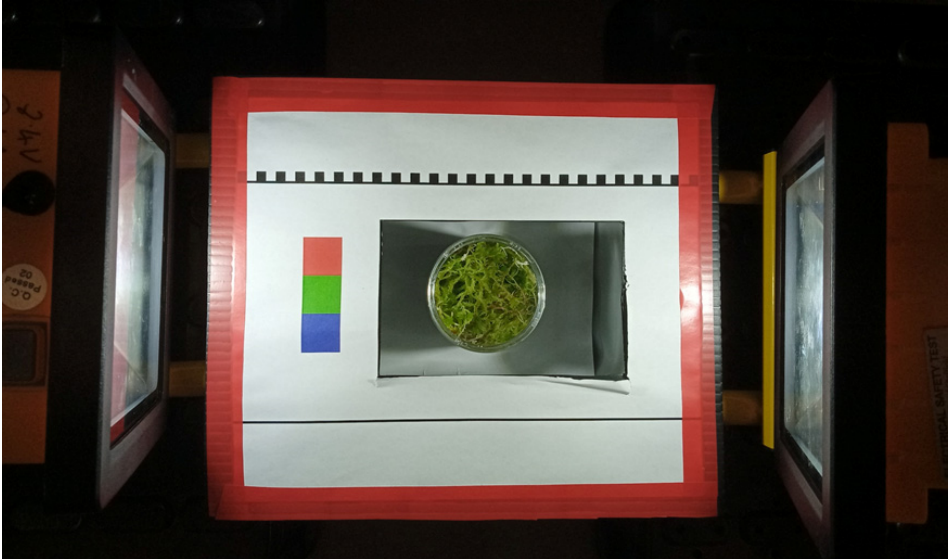
Figure 3. A sample of Sphagnum moss ready for image capture using the hand-held Hyperspectral Smartphone and the in-scene reference card.